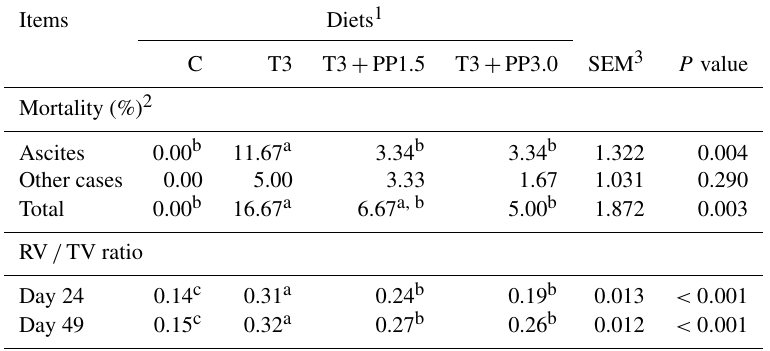
Table 2. Effects of dietary treatments on mortality rate (0–49 days of experiment) and right ventricle to total ventricle (RV / TV) ratio in broiler chickens slaughtered at 24 and 49 days of experiment. Items Diets 1 C T3 T3 + PP1.5 T3 + PP3.0 SEM 3 P value Mortality (%) 2 Ascites 0.00 b 11.67 a 3.34 b 3.34 b 1.322 0.004 Other cases 0.00 5.00 3.33 1.67 1.031 0.290 Total 0.00 b 16.67 a 6.67 a, b 5.00 b 1.872 0.003 RV / TV ratio Day 24 0.14 c 0.31 a 0.24 b 0.19 b 0.013 < 0 . 001 Day 49 0.15 c 0.32 a 0.27 b 0.26 b 0.012 < 0 .